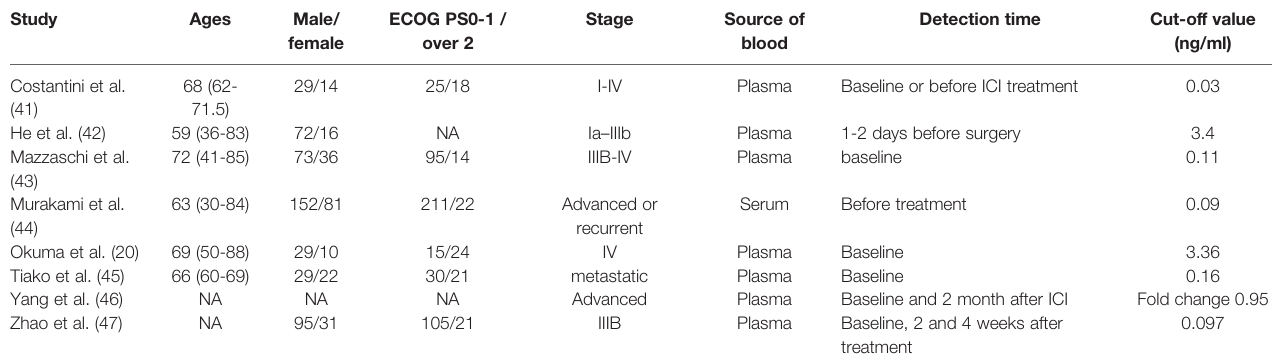
TABLE 2 | The characteristic of included